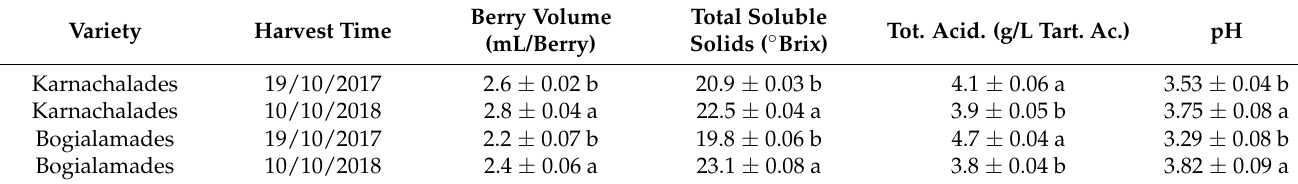
Data represent Mean ± St. Deviation (St. Dev.) followed by the same letter, in the column, do not differ by t -test at 5% probability.